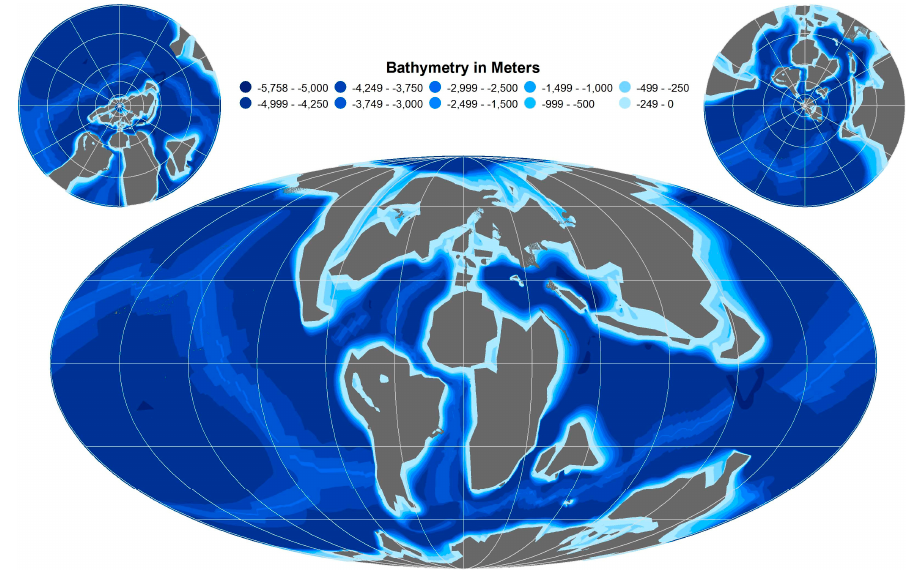
Figure 7. The 94 Ma reconstructed base bathymetry with isostatically adjusted, multicomponent sediment layer and shelf-slope-rise structure.